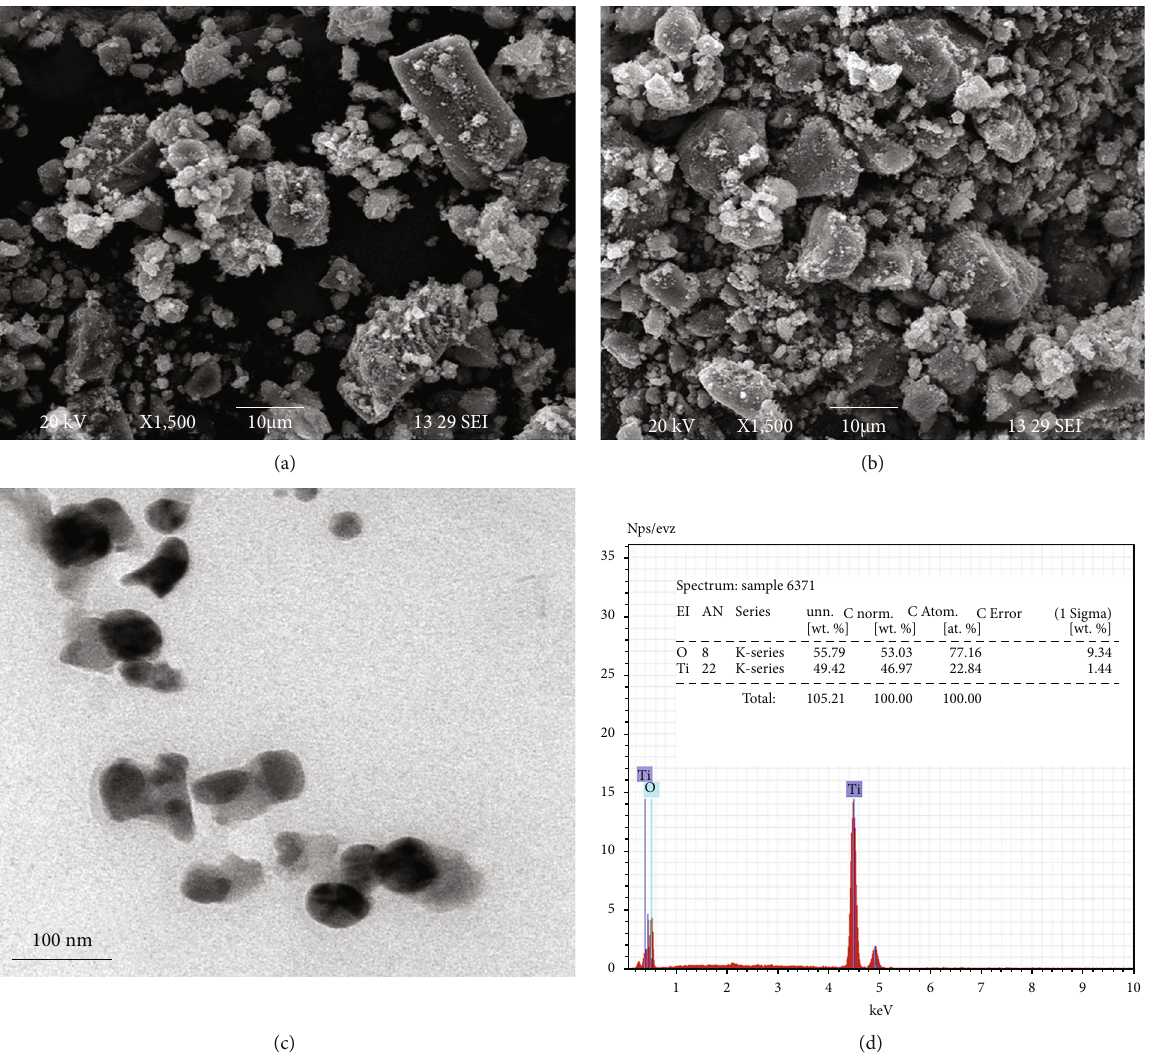
Figure 6: (a, b) SEM images of TiO